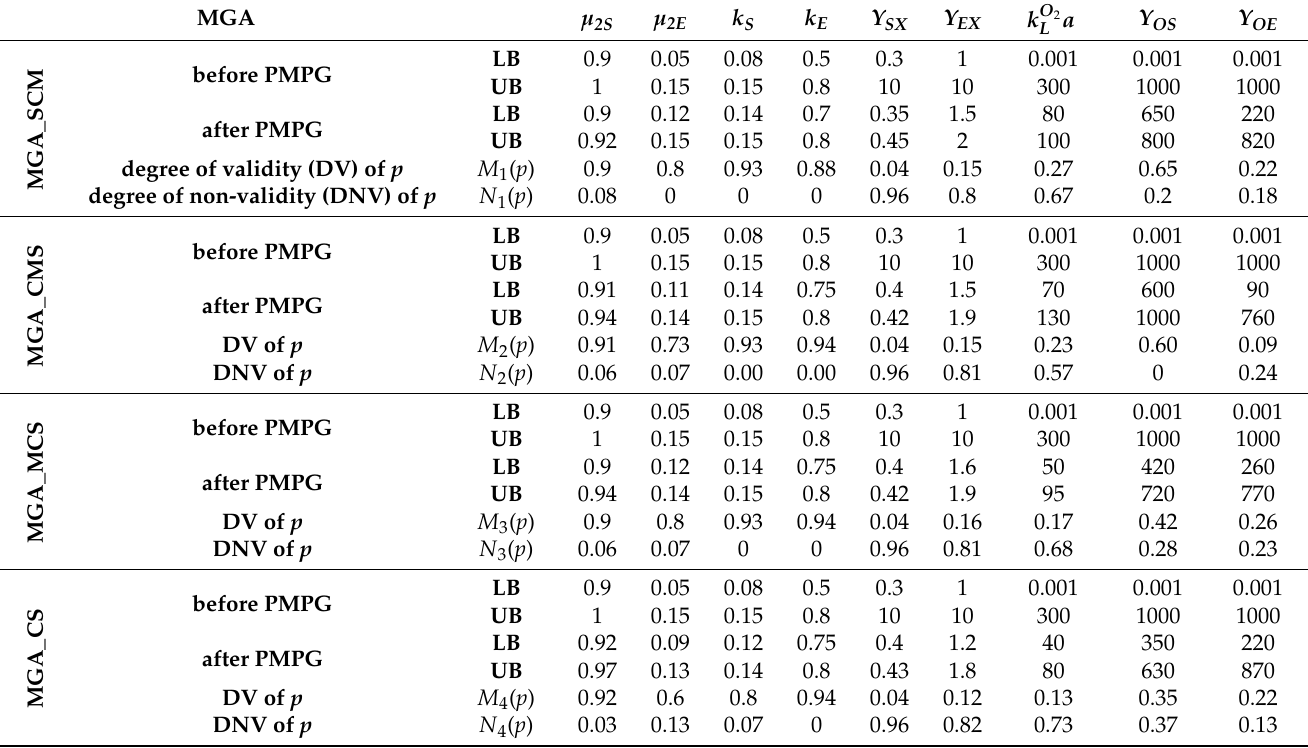
Table 3. Boundaries of model parameters for investigated